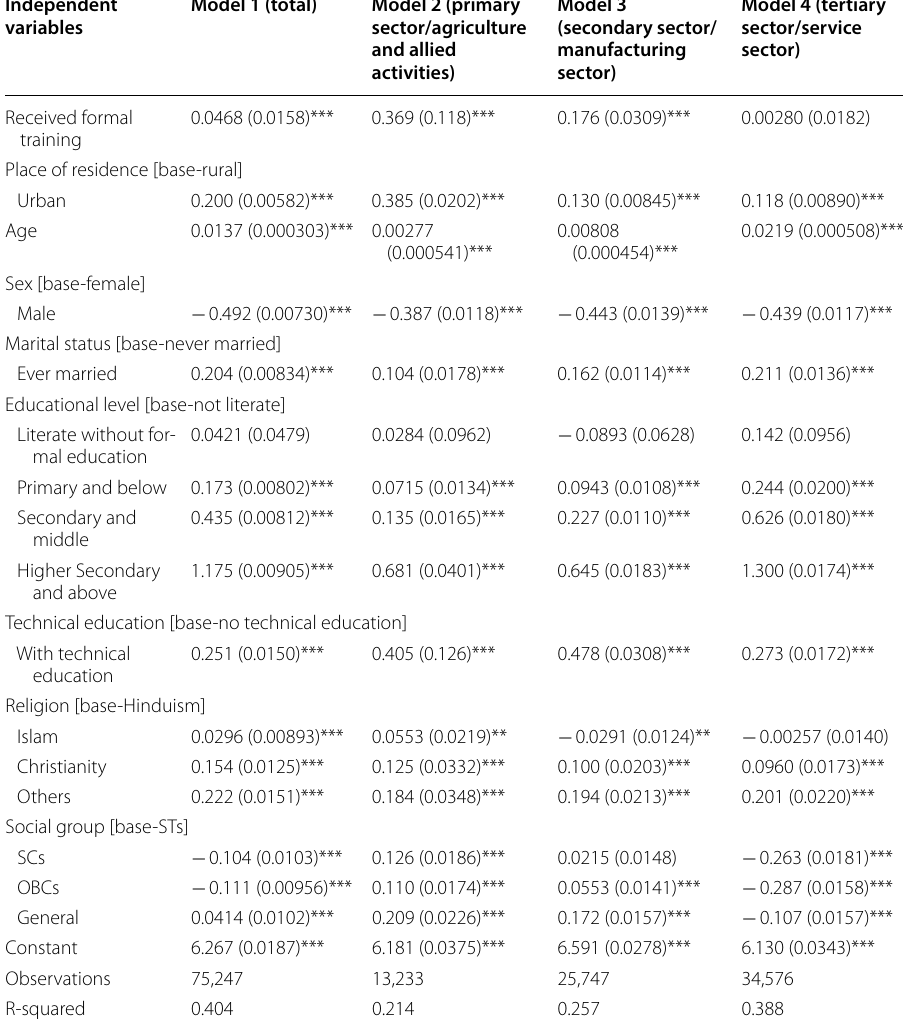
Standard errors in